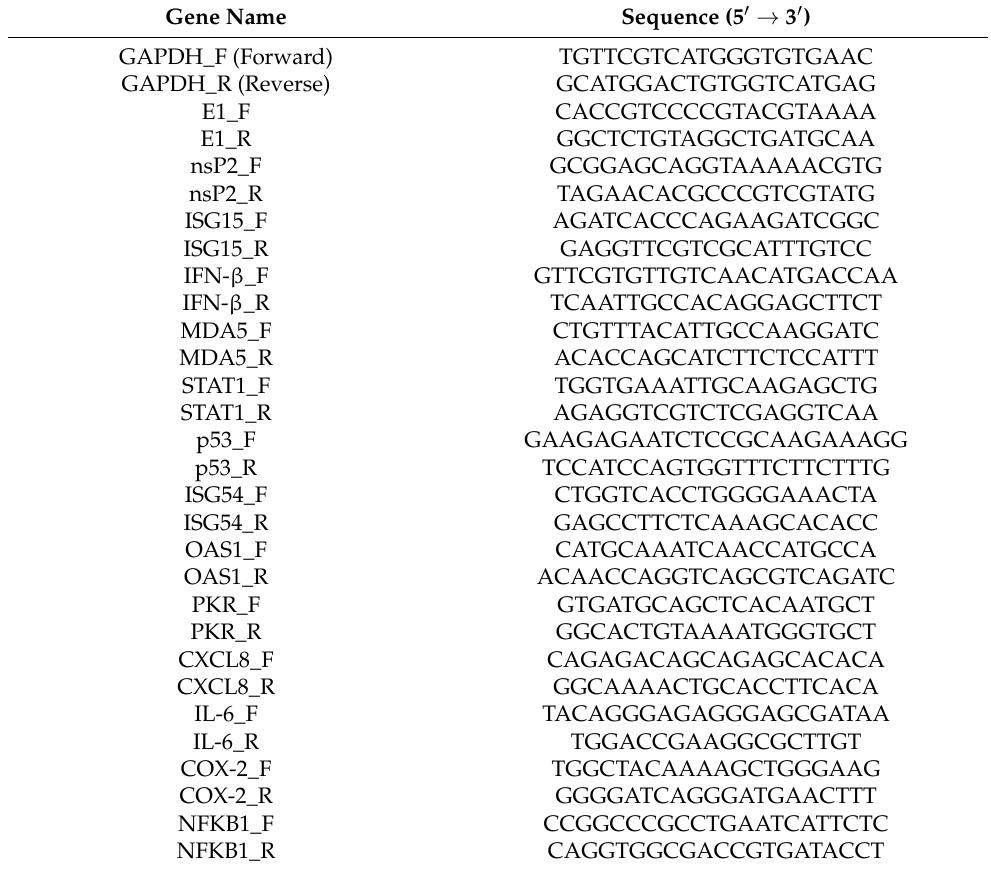
Table 1. List of primers used for